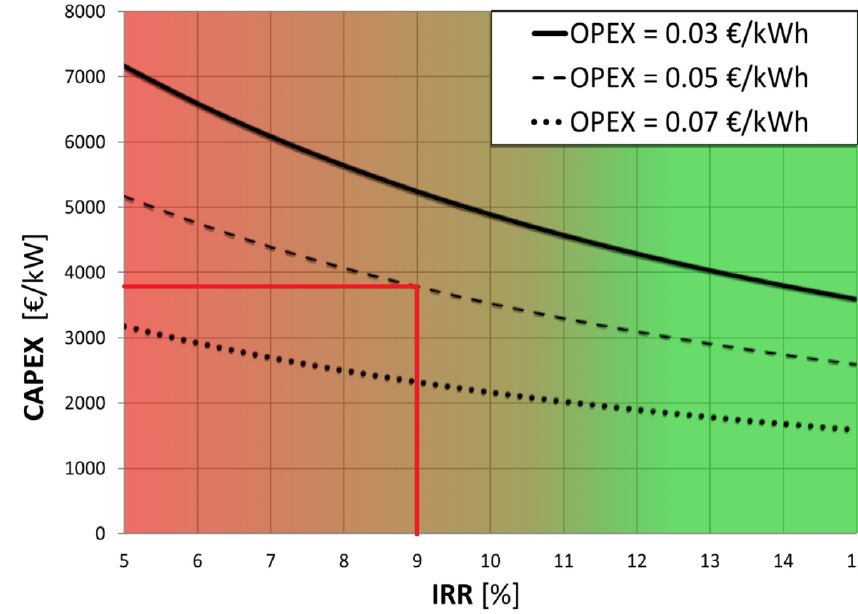
Figure 3. Results of the variable NPV analysis.